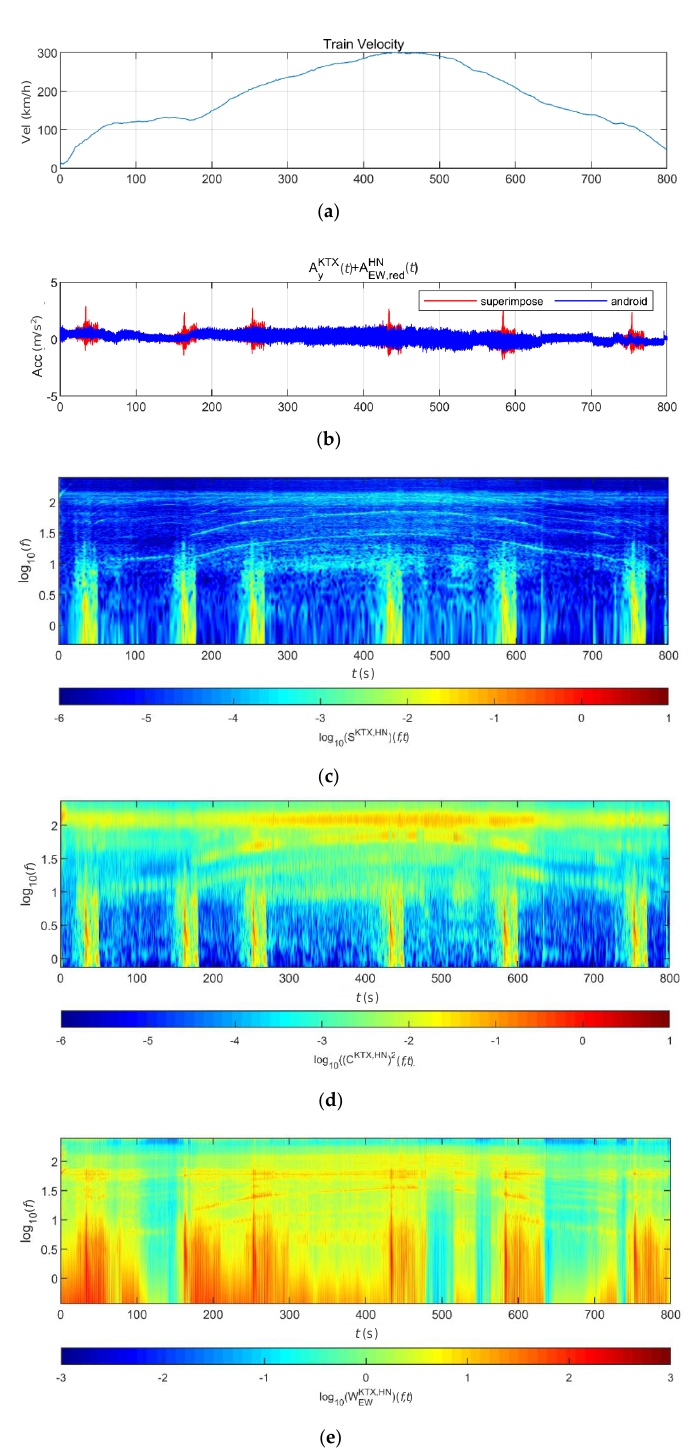
Figure 26. Combination of train data with the Hachinohe earthquake data (scaled to 1000-year return period): ( a ) velocity; ( b ) lateral acceleration time series; ( c ) STFT; ( d ) WT; ( e ) WVD.